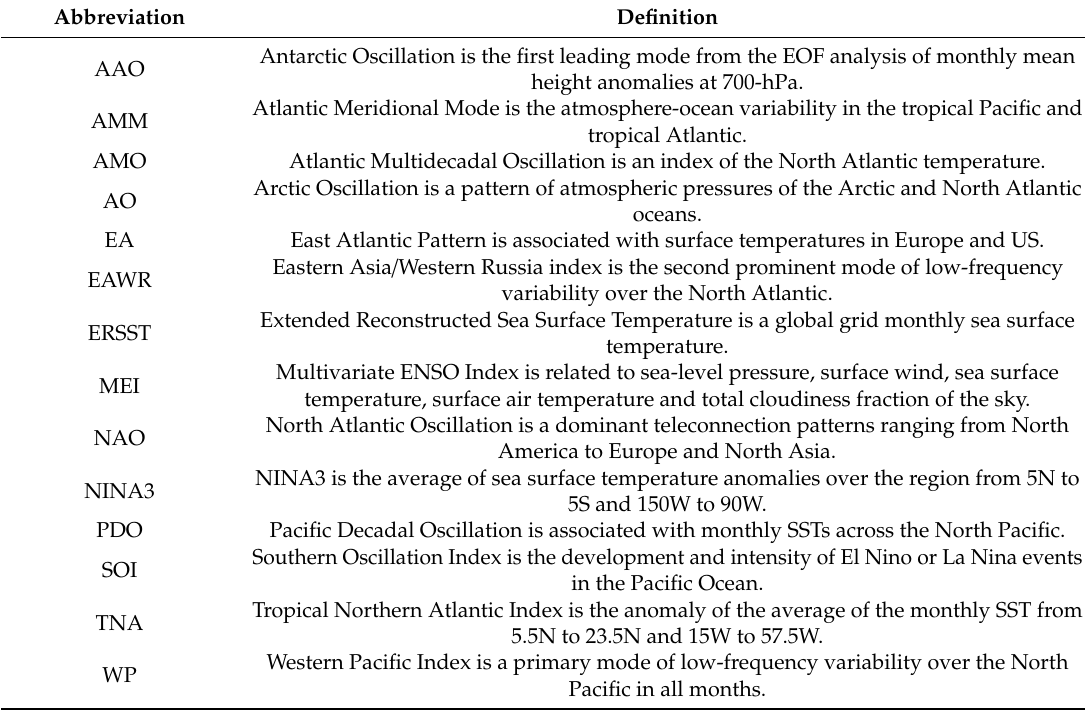
Table 2. List of teleconnection indices used in this